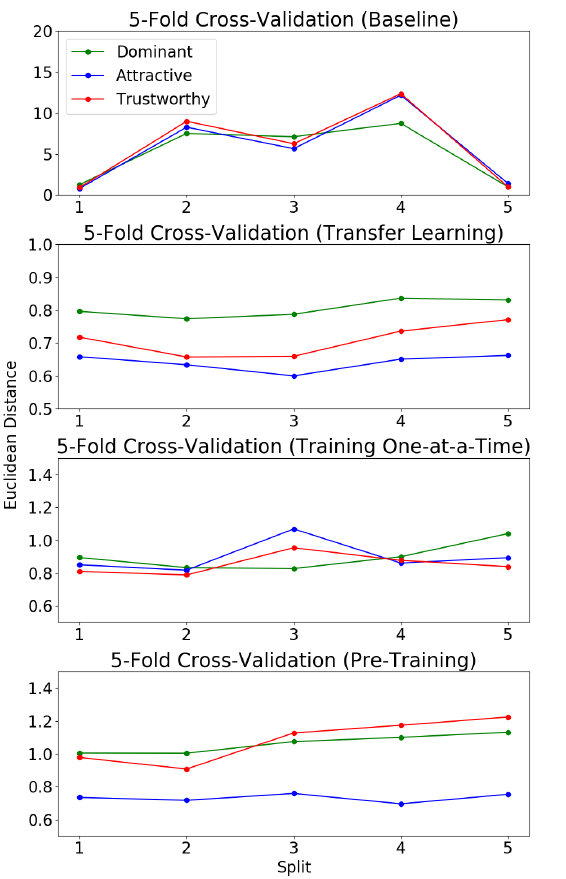
Figure 7. Five-fold cross-validation on each regression model trained over 50